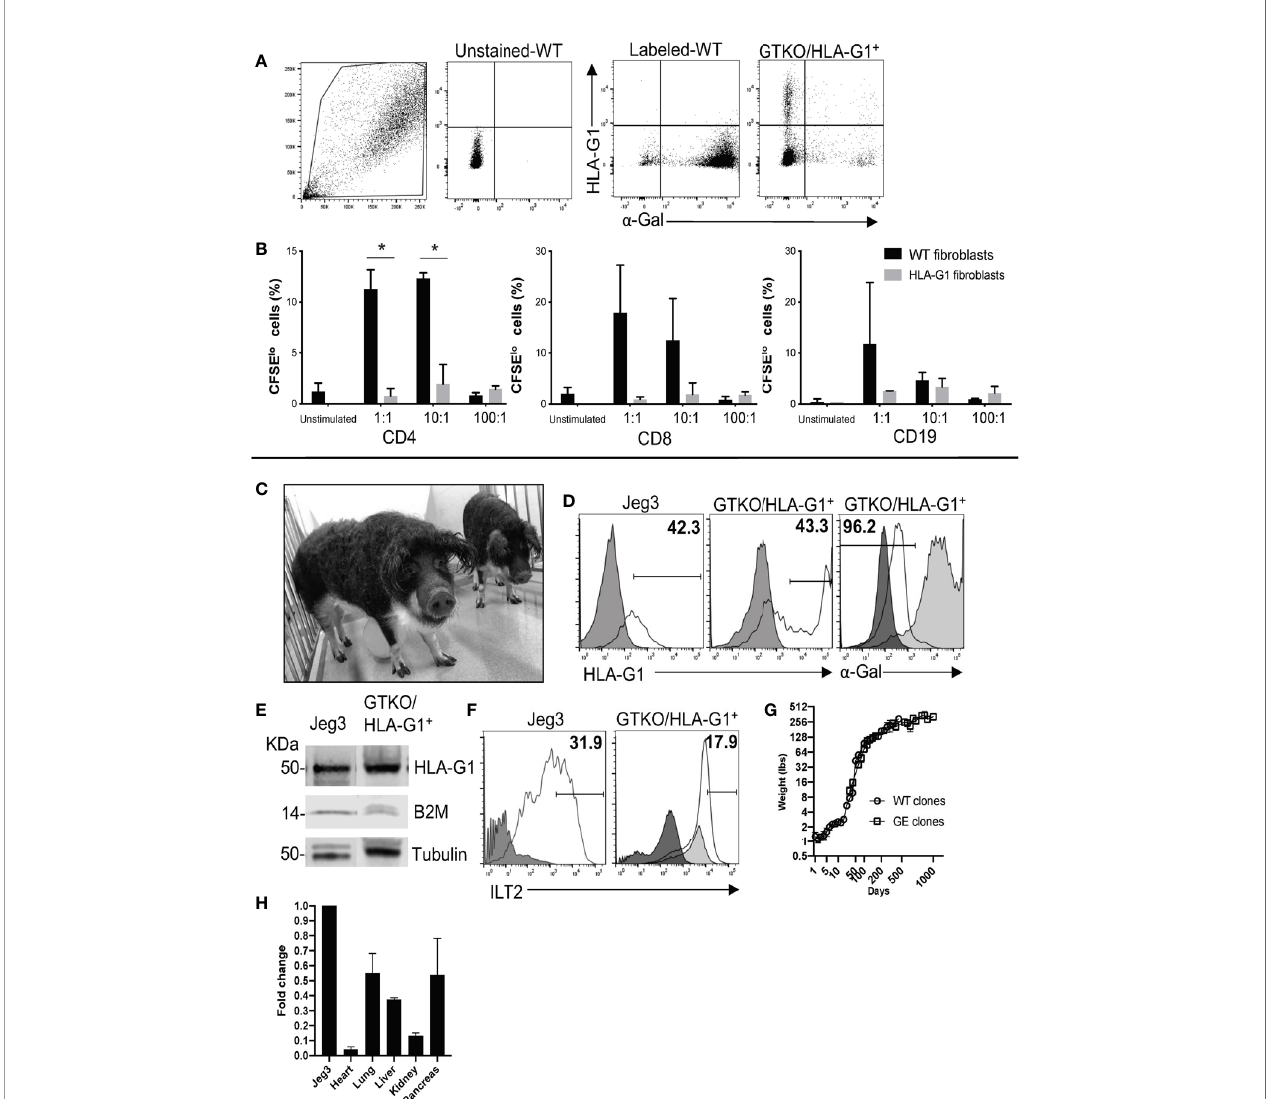
FIGURE 2 | Creation and characterization of GTKO/HLA-G1 + pigs. (A) Flow sorting of GTKO/HLA-G + cells beginning with forward and side scatter gate, unstained cell gating, untreated wild-type (WT) cell gating, and selected genetically engineered cells based on those gates. IB 4 lectin and anti-HLA-G (clone 87G) monoclonal antibody were used to identify GGTA - and HLA-G + cells, respectively. (B) Sorted cells were examined for functional expression of HLA-G by co-culture with hPBMC (3 x 10 5 ) at ratios of 1:1, 10:1, and 100:1 with sorted cells for fi ve days. Data shown are presented as mean ± SD. Proliferation of CD4 + T cells, CD8 + T cells, and CD56 + NK cells by HLA-G + GGTA1 - cells were measured by fl ow cytometry as a decrease in CFSE fl uorescence. Prior to co-culture, hPBMCs were labeled with CFSE (2 µM), where dilution of CFSE was considered extent of proliferation. (C) Photograph of GTKO/HLA-G + pigs generated by SCNT. (D) Expression of GGTA1 on skin fi broblasts derived from transgenic pigs (black line) compared to WT pig cells (medium grey) and unlabeled cells (dark grey). Human Jeg3 cells positive for HLA-G1 were used as a positive control. Unstained cells in dark grey were compared to anti-HLA-G labeled cells (clone 87G) shown as black line. Gates were based on the unstained cell fl uorescence. (E) Western blot analysis of GTKO/HLA-G1 + transcript driven by the porcine ROSA26 promoter as detected with b 2m and tubulin and compared to positive control Jeg3 cells. (F) Recombinant ILT2 bound to HLA-G1 positive porcine fi broblasts (black line) as compared to fl uorescent streptavidin control (medium grey) and unlabeled cells (dark grey). JEG3 cells labeled with rILT2 were used as positive controls (black line) and compared to unlabeled cells (dark grey). (G) Comparison of weight gained by pigs, WT clones to GE clones, over a period of 1000 days of life. (H) Quantitative real time PCR of various transplantable organs from GTKO/HLA-G1 + to positive control JEG3 tissues demonstrating fold change corresponding to gene